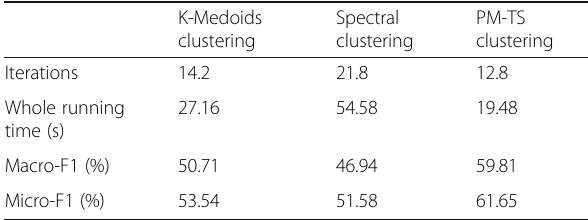
Table 2 Average performances of the three